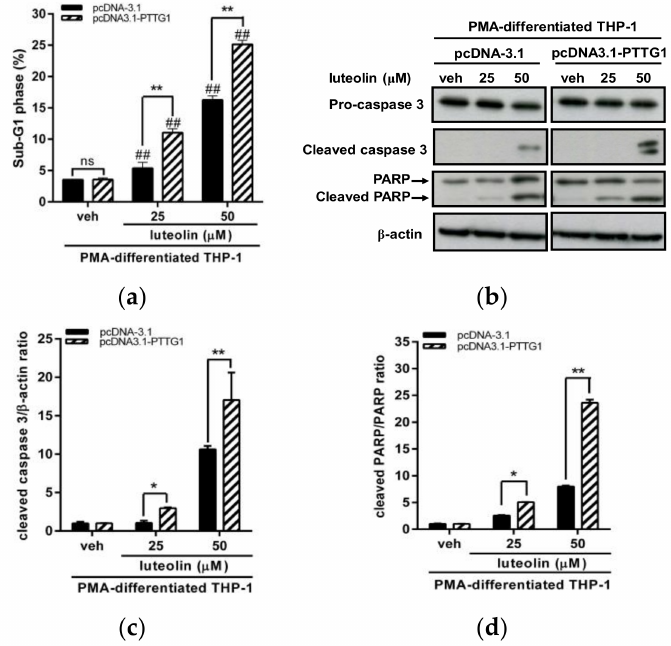
Figure 4. Effects of PTTG1 overexpression on luteolin-induced apoptosis in PMA-differentiated THP-1 cells. ( a ) The PMA-differentiated THP-1 cells were transfected with pcDNA-3.1 control vector or pcDNA3.1-PTTG1 expression plasmid for 48 h followed by treatment of vehicle or luteolin (25 and 50 µ M) for 24 h, and then, the cell population in sub-G1 phase of cell cycle was determined by flow cytometric analysis. The experiments were triplicated, and the data are presented as the means ± SD from three independent experiments. ## p < 0.01 represents a significant difference compared to vehicle-treated cells. ** p < 0.01 represents a significant difference compared to the pcDNA-3.1 control vector-transfected cells. “ns” represents no significant. ( b ) Proteins including pro-caspase 3, cleaved caspase 3, PARP1, cleaved PARP1 and β -actin were analyzed by Western blot analysis. The experiments were triplicated, and a representative blot is shown. ( c ) The intensity of cleaved caspase 3 versus β -actin proteins is normalized and presented as the mean ± SD of triplicated experiments. ( d ) The intensity of cleaved PARP1 versus total PARP1 proteins is normalized and presented as the mean ± SD of triplicated experiments. * p < 0.05 and ** p < 0.01 represent a significant difference compared to the pcDNA-3.1 control vector-transfected